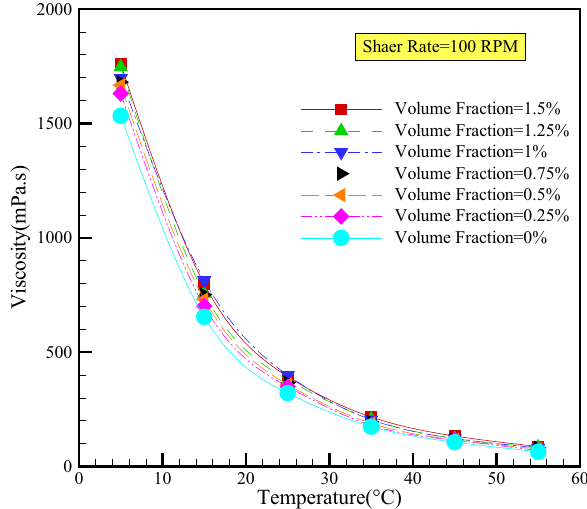
Figure 8. Effect of temperature on dynamic viscosity for various VFs in constant SR of 100 rpm.